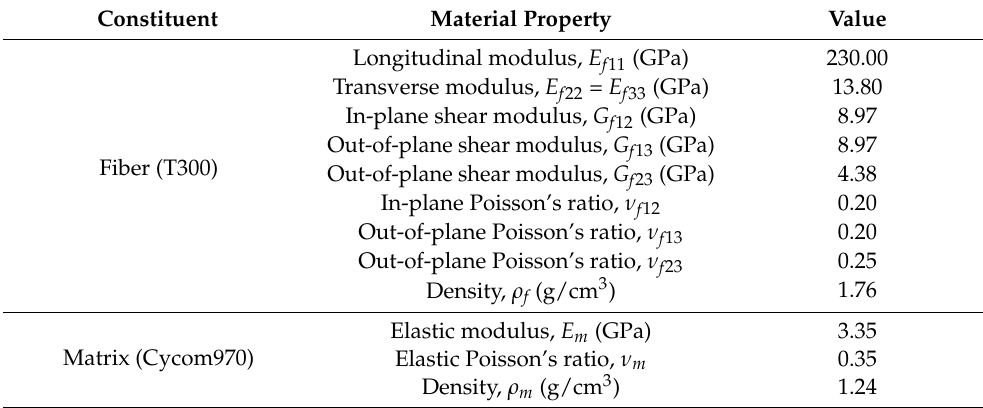
Table 1. Mechanical properties of the fiber and matrix constituents in the T300/Cycom970 composite.